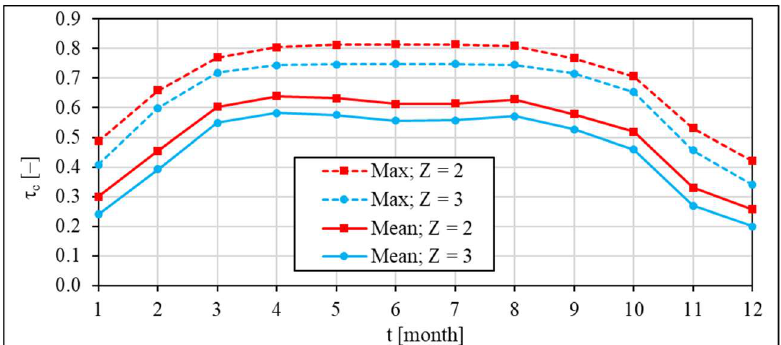
Figure 9. Mean twenty-four-hour and maximal values of TST for characteristic days of the year (solar ray reflections from two surface or three surface polycarbonate channels).